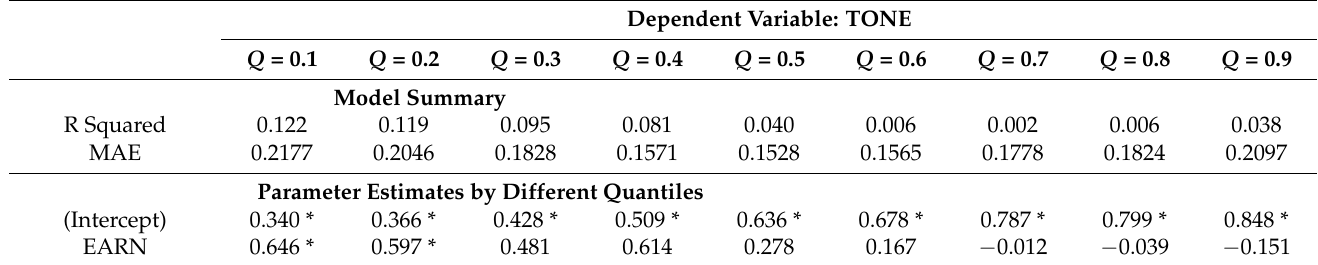
Table 6. Univariate statistics and parameter estimates for EARN on TONE.